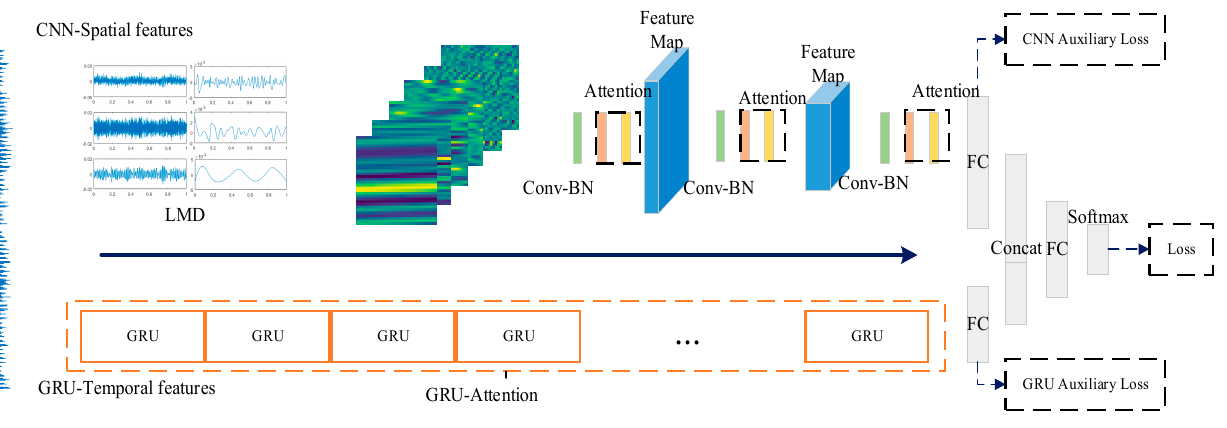
Figure 9. Spatiotemporal feature fusion network.